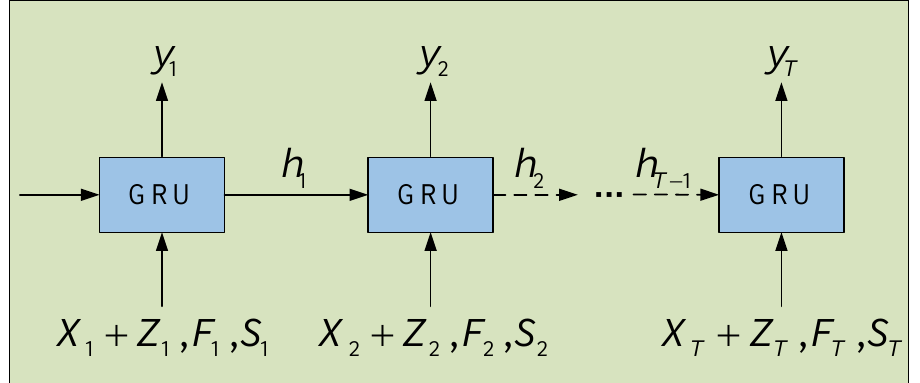
Figure 8. The structure of the generator of STA-GAN